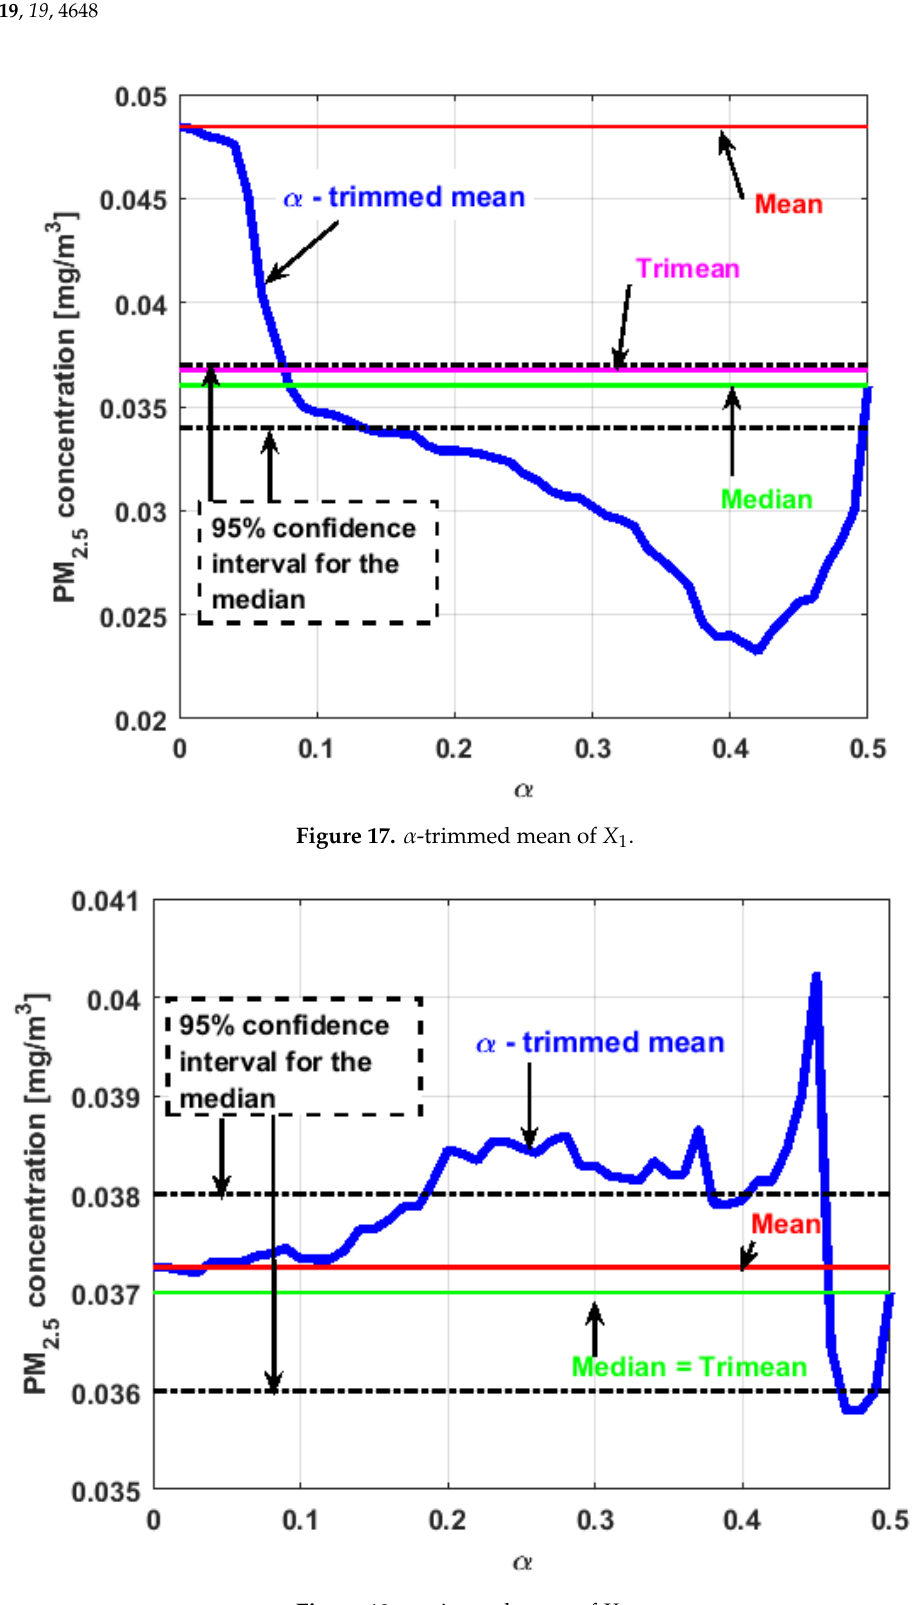
Figure 18. 𝛼 -trimmed mean of 𝑋 2 . Figure 18. α -trimmed mean of X 2